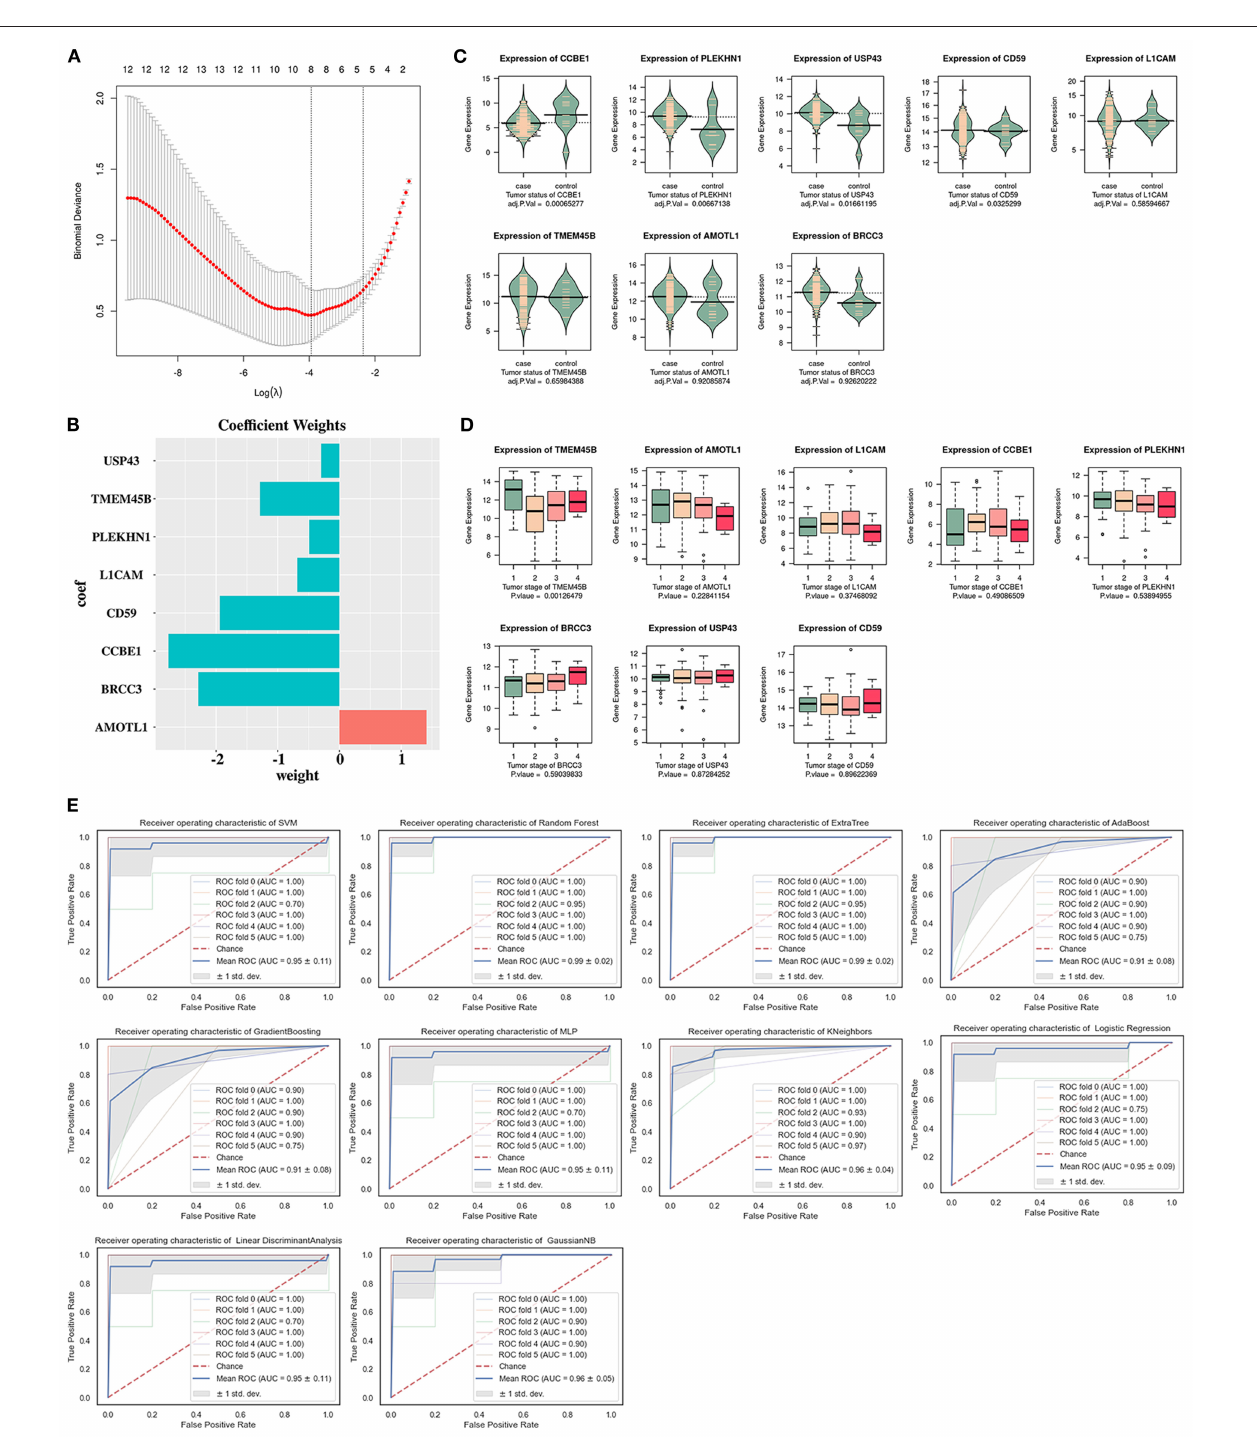
FIGURE 6 | Identification of the non-paclitaxel resistance-specific key genes by least absolute shrinkage and selection operator (LASSO) analysis based on GSE161533. (A) Cross-validation of LASSO analysis of the non-paclitaxel resistance-specific key genes. (B) Coefficient weights of the non-paclitaxel resistance-specific key genes. (C) Expression levels of the non-paclitaxel resistance-specific key genes in the tumor group compared with the normal group based on The Cancer Genome Atlas Esophageal Carcinoma (TCGA-ESCA). (D) Expression levels of the non-paclitaxel resistance-specific key genes in four tumor stages based on TCGA-ESCA. (E) Area under the ROC curve (AUC) values of 10 esophageal squamous cell carcinoma (ESCC) classifiers of the non-paclitaxel resistance-specific key genes based on GSE161533.